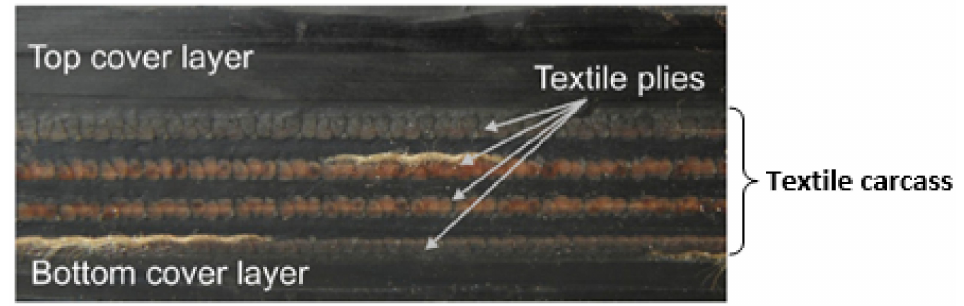
Figure 1. Rubber-textile composite conveyor